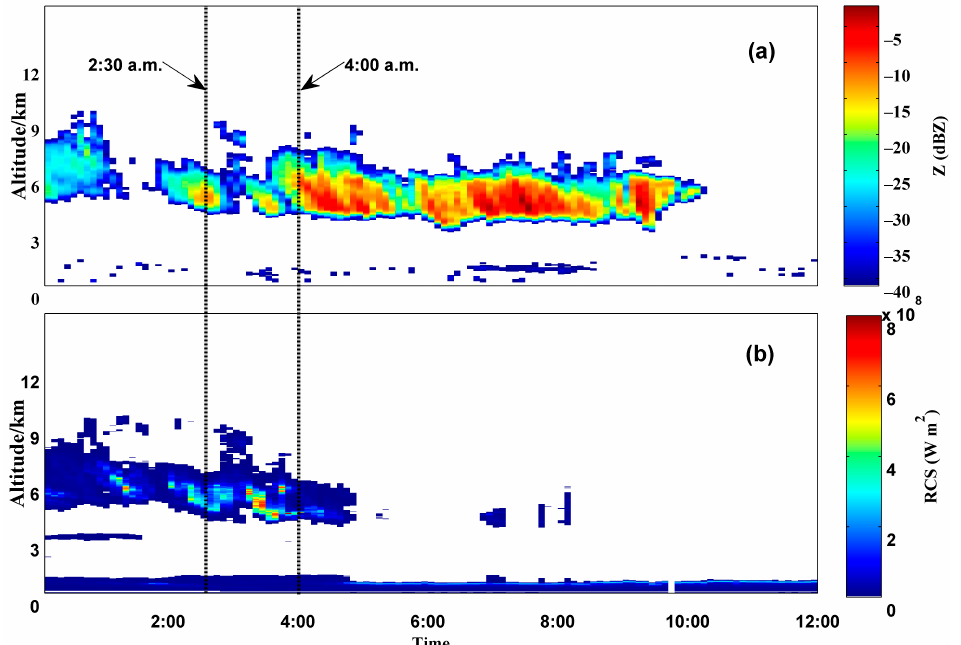
Figure 9. Time–height profile of Z ( a ) and 1064 nm ranged corrected signal (RCS) ( b ) on 10 October 2019.